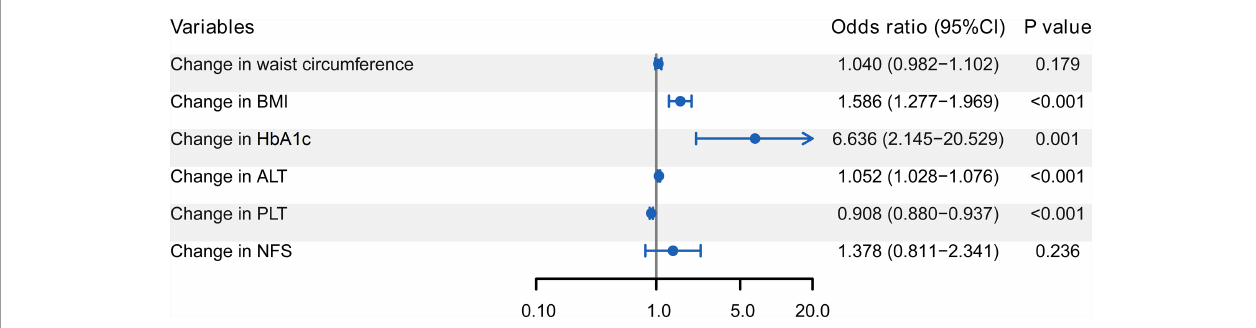
FIGURE 2 | Forest plot of multivariate Logistic regression analysis for the associations between independent factors and fi brosis progression. Changes in BMI, HbA1c, ALT, and PLT are the independent factors associated with the fi brosis progression. BMI, body mass index; HbA1c, glycosylated hemoglobin A1c; ALT, alanine aminotransferase ratio; PLT, platelet counts; NFS, NAFLD fi brosis